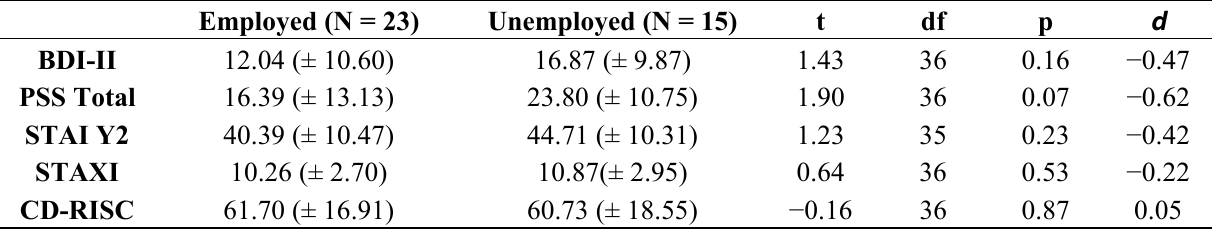
Table 3. Mean self-report questionnaire scores and differences between employed and unemployed injured workers. Values are mean ± S.D.